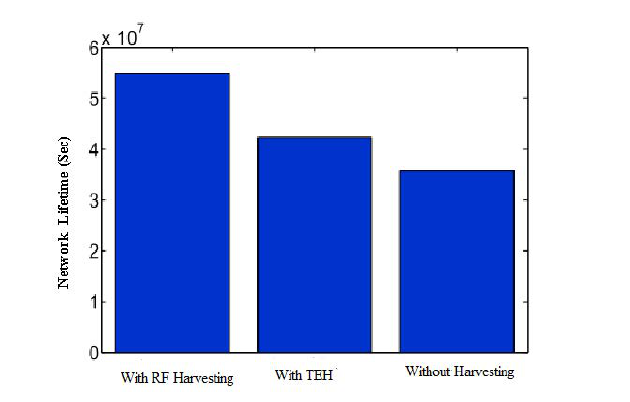
Figure 8. Comparative analysis of RF and thermal energy harvesting. TEH: Thermoelectric Harvesting. Figure 9 investigates the impact of the energy harvesting mechanism on lifetime maximization.